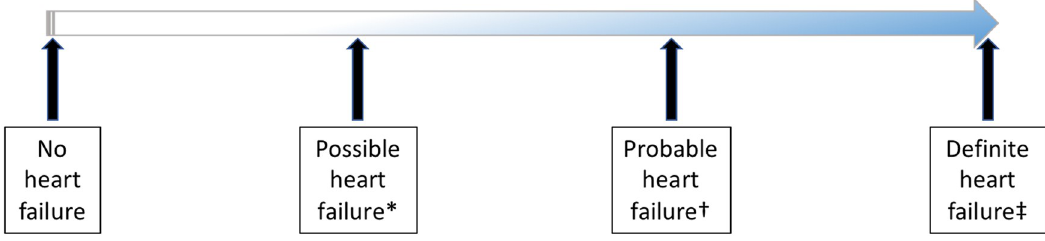
Fig 1. Clinical uncertainty in establishing heart failure